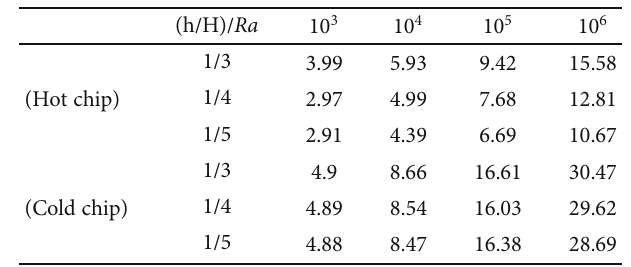
Table 2: Vortex center location for di ff erent Rayleigh numbers for hot and cold chip cases.